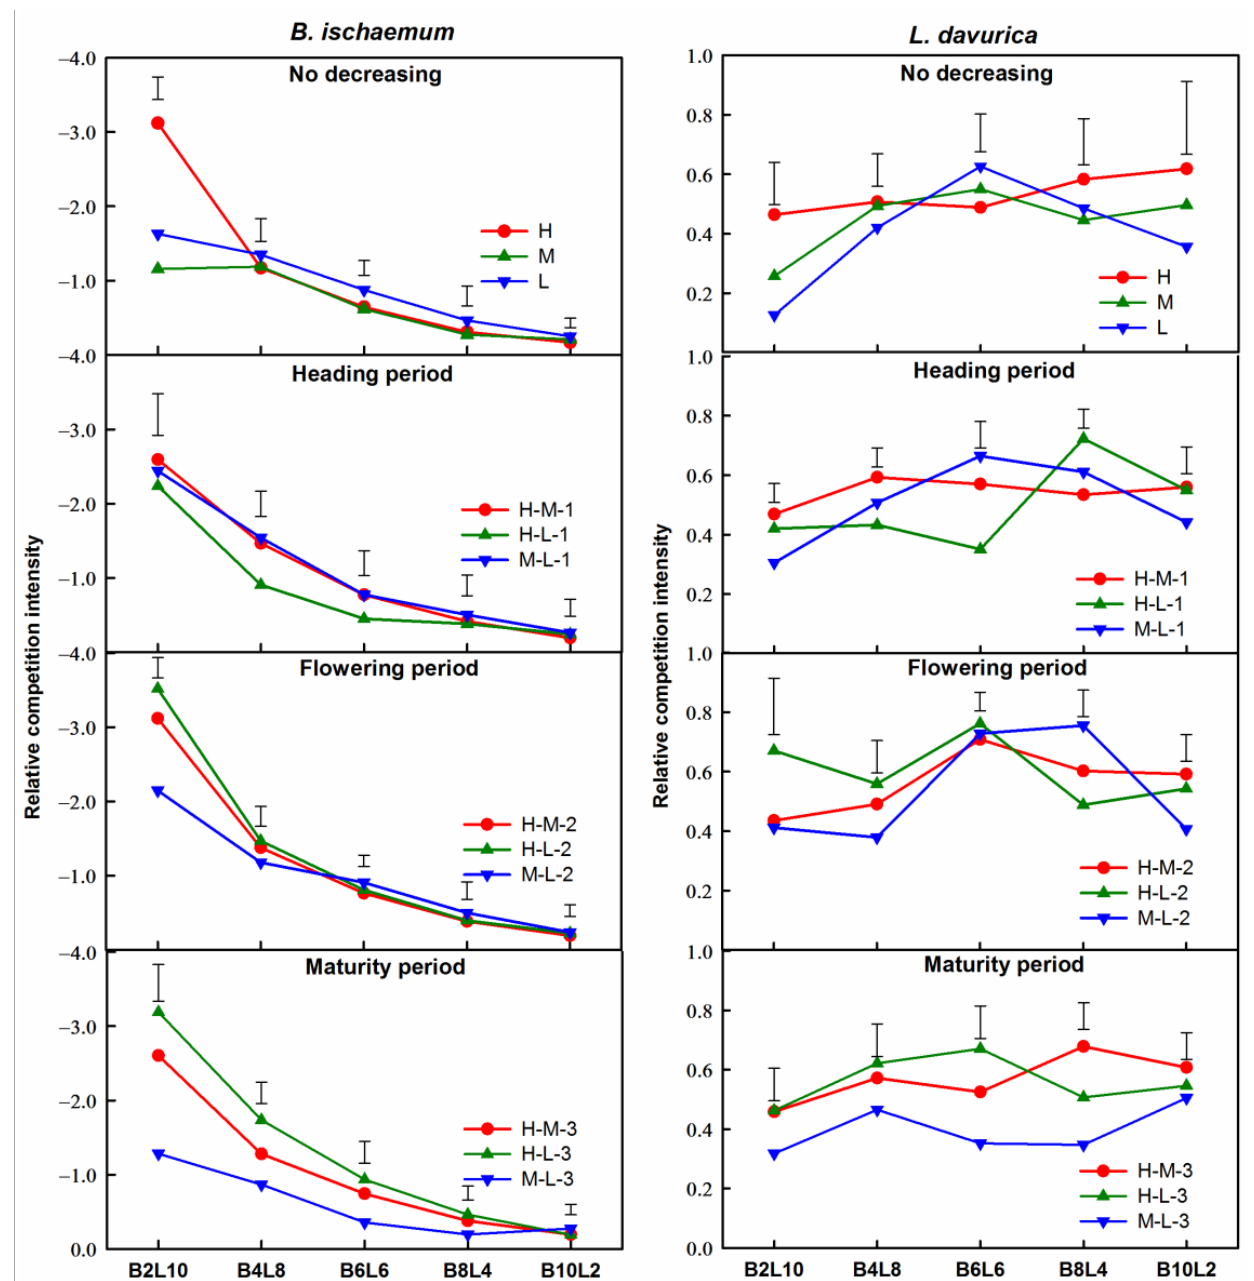
Figure 4. Relative competition intensity (RCI) of B. ischaemum (B) and L. davurica (L) in their mixtures under soil water decreasing treatments. Vertical bars represent LSD 0.05 values.